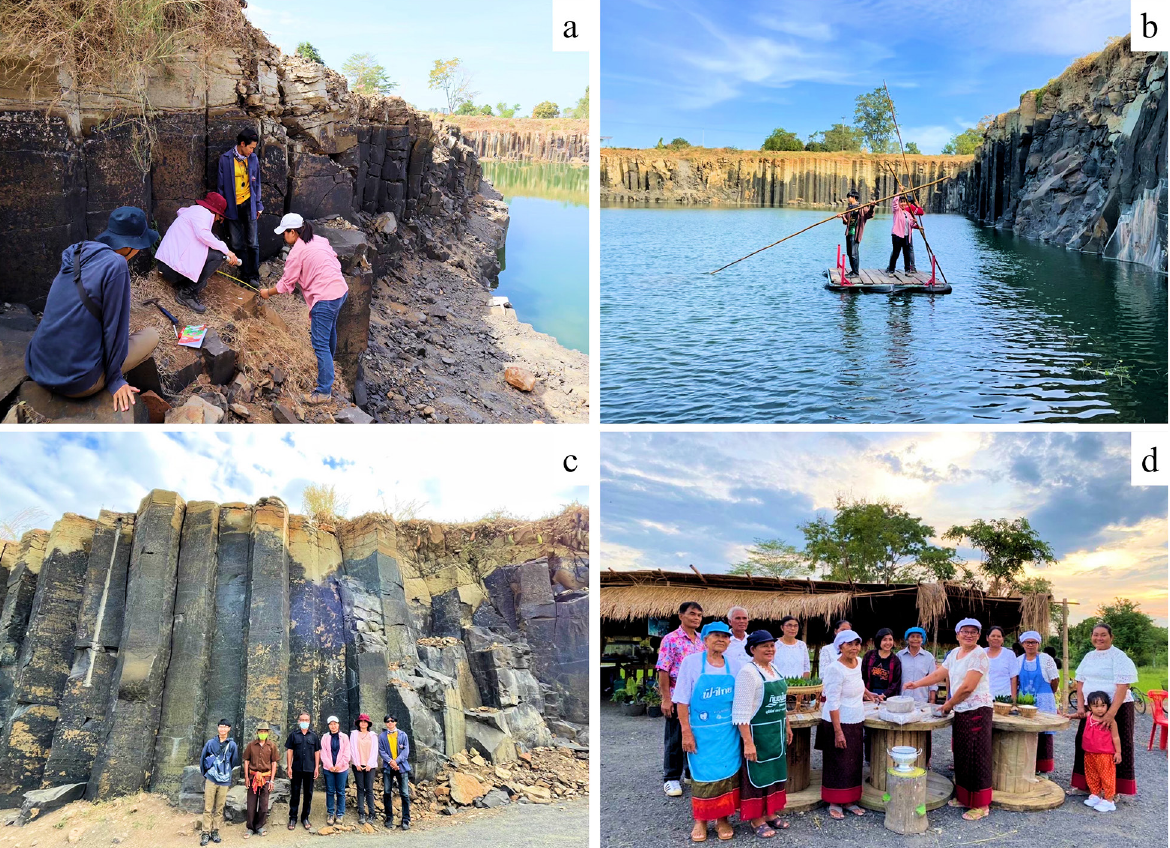
Fig. 8. Geotourism Perspectives: a – research activity of Geotechnology undergraduate students, b – rafting activities, c – local authorities, local people, and students group shot d – local people and their food